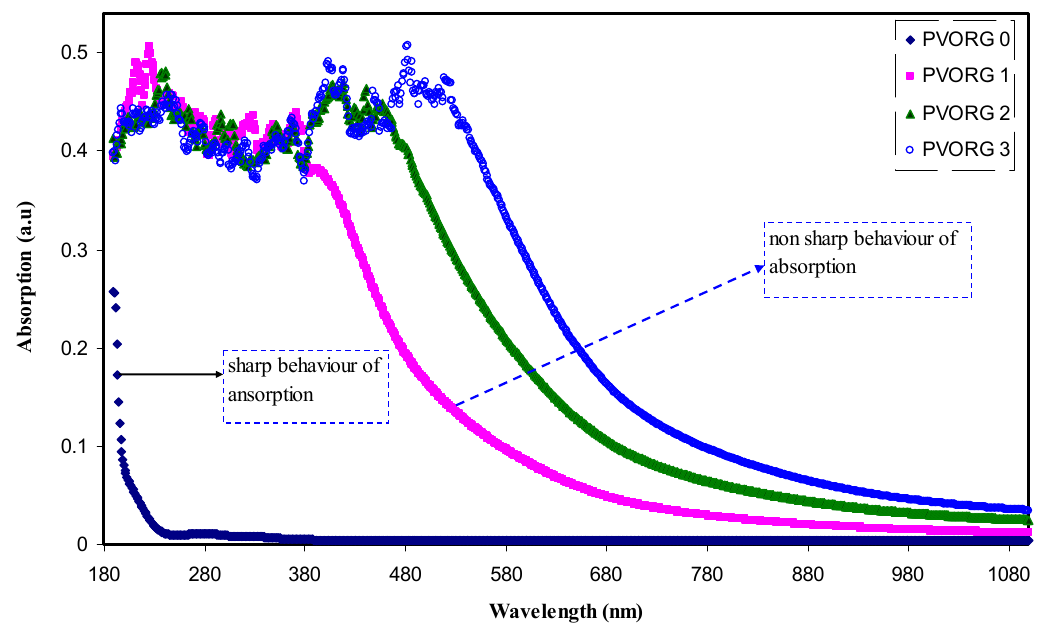
Figure 7. Absorption spectra of pure PVA (PVORG0) and PVA composite films.